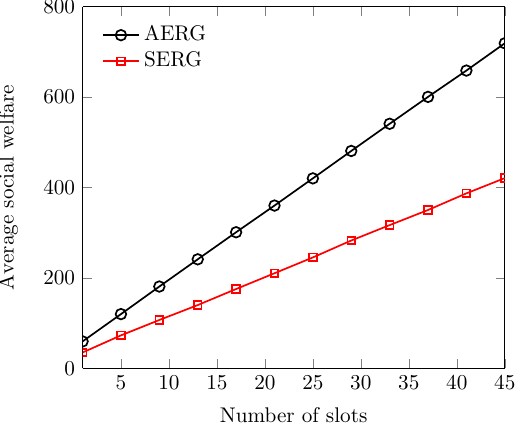
Figure 8. Social welfare vs. number of slots. SERG, Static and Economically-Robust Group selling.